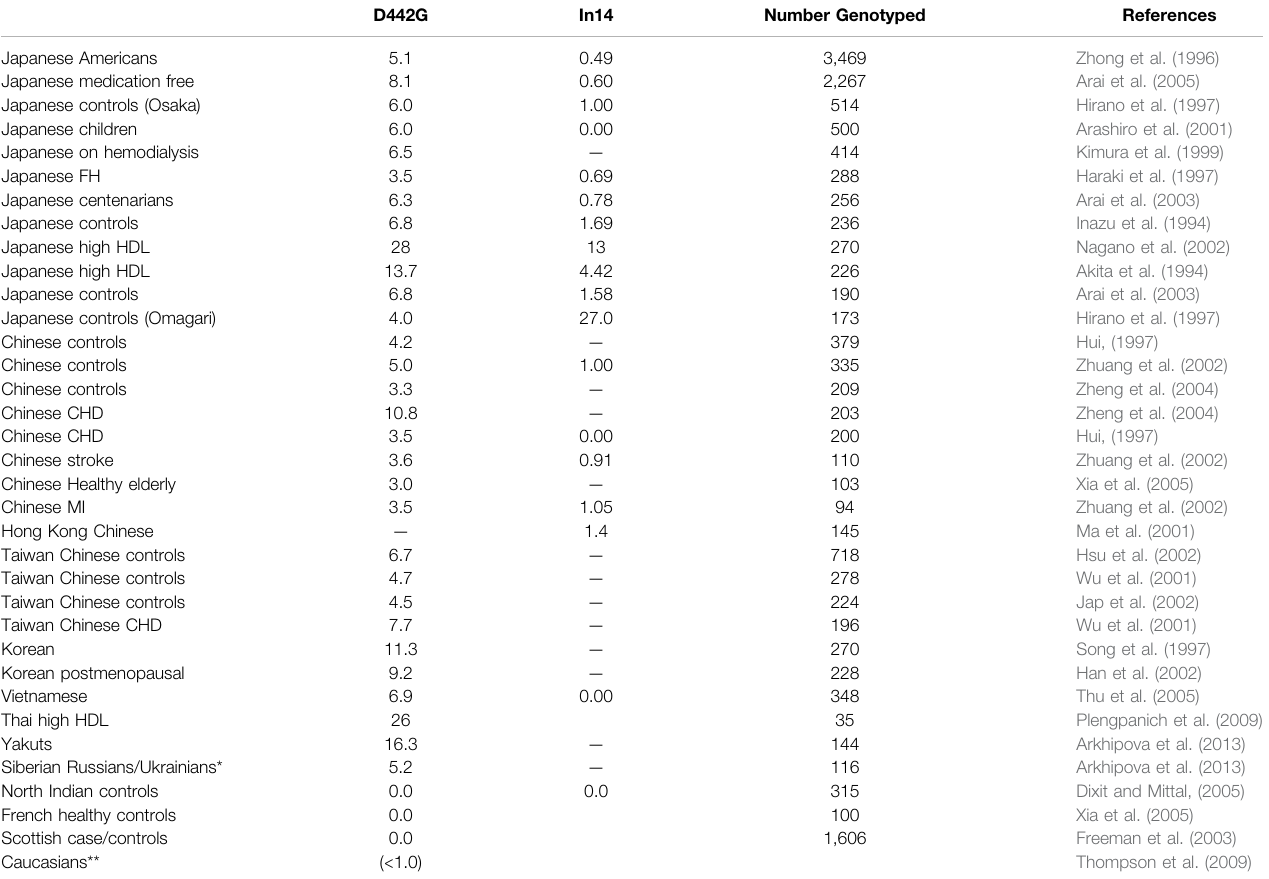
TABLE 2 | Frequency of CETP de fi ciency in various regions of the world as prevalence of mutants in population